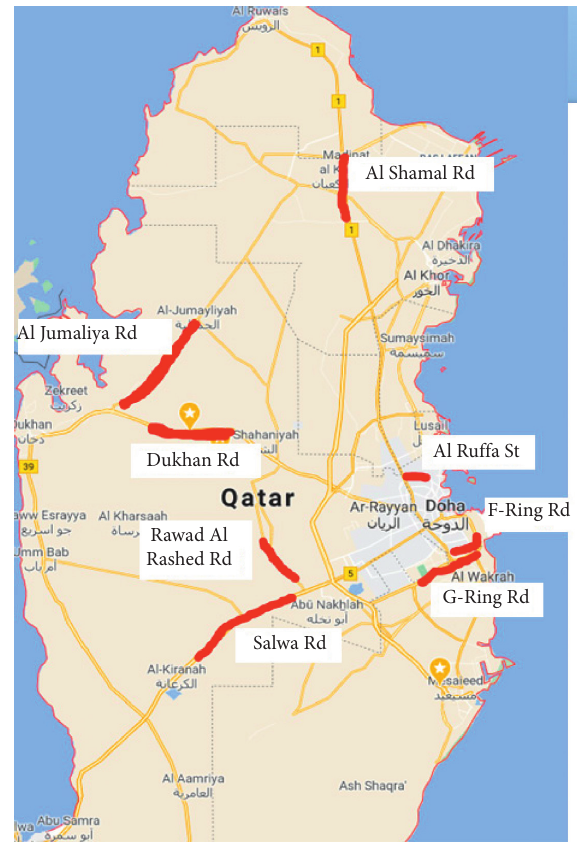
Figure 2: Location of OBSI test